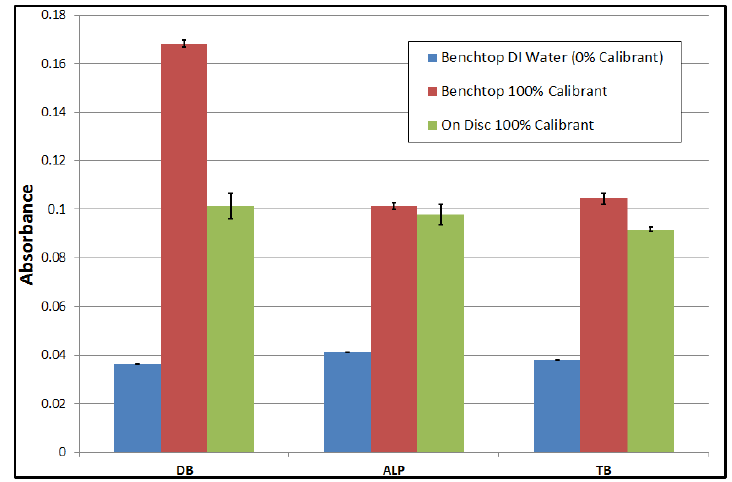
Figure 9. Comparison of benchtop results (n = 5) versus sample processed on disc (n = 3). The 0% calibrant (i.e., for baseline subtraction) was DI water. The 100% calibrants are 21.2 µmol L −1 DB, 127 U L −1 ALP, and 29.2 μmol L −1 , respectively.